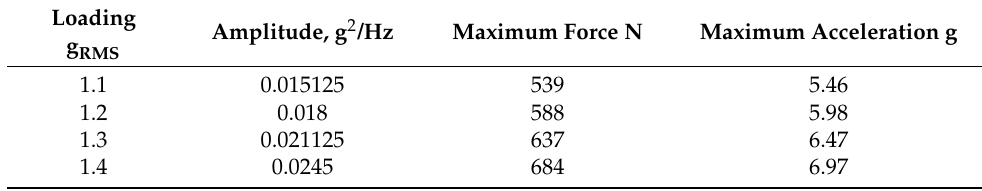
Table 1. Experimental loading conditions for kurtosis Ku = 3.